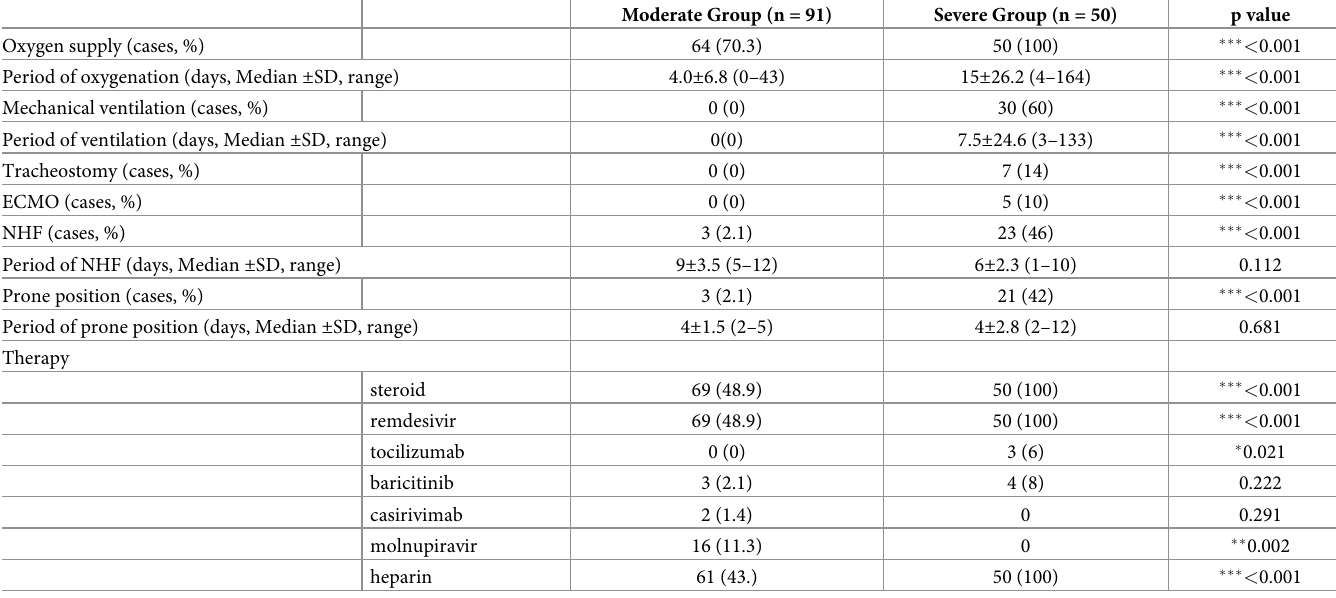
Table 4. Therapeutic strategy between moderate group and severe